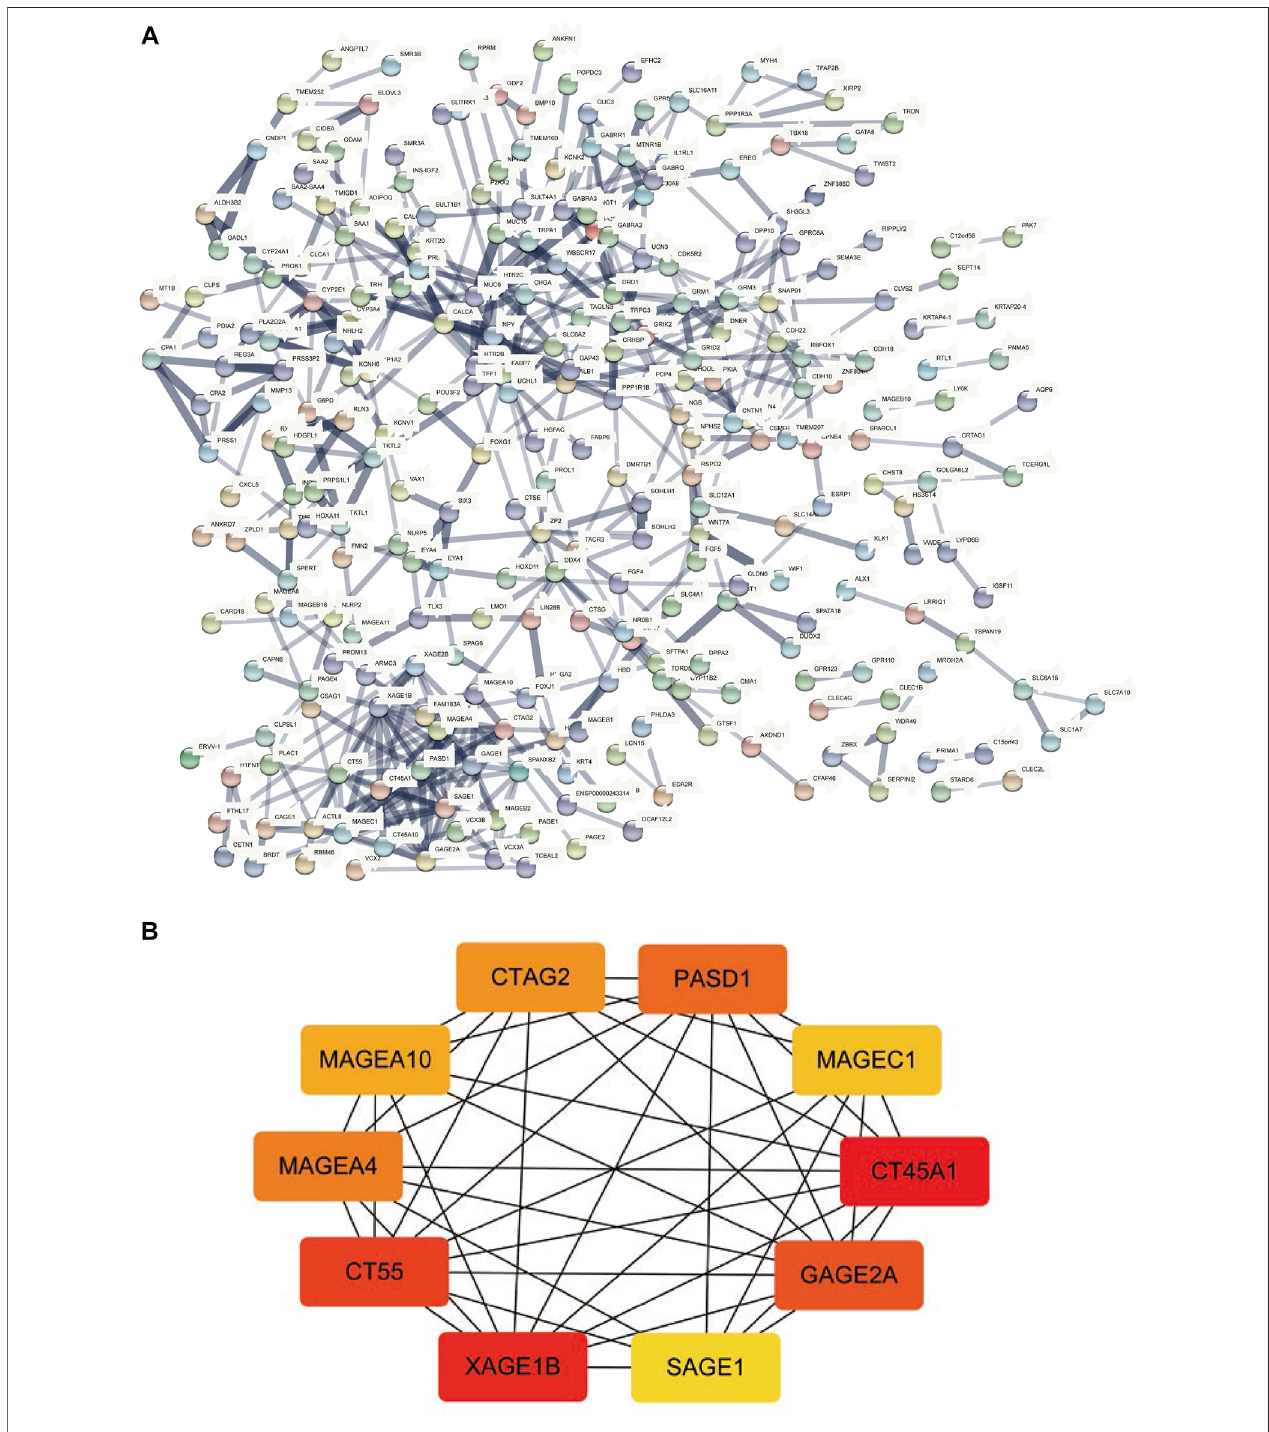
FIGURE6| PPInetworkconstructionandhub-genescreening. (A) :PPInetworkofdifferentiallyexpressedgenes. (B) :Getthetop10genesaccordingtotheMCC algorithm, the redder the color, the more important.